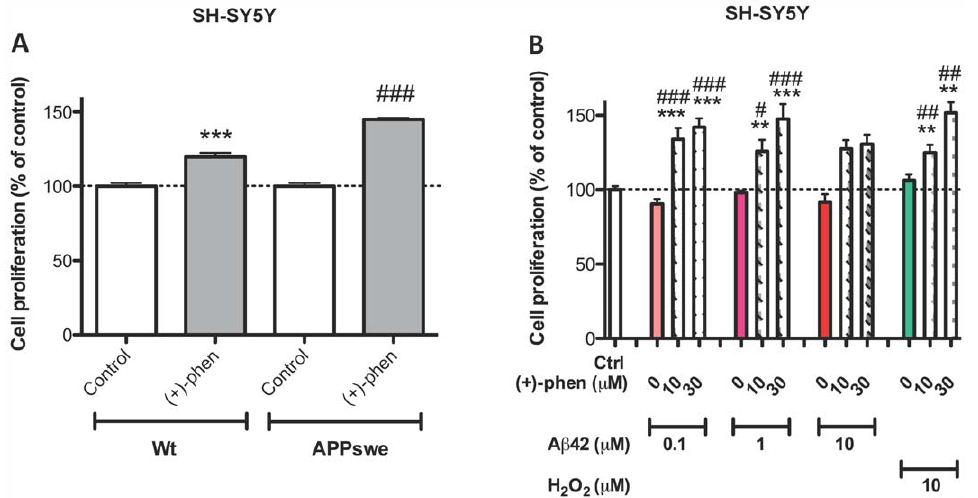
Figure 2. Neurotrophic actions retained in APPswe transfected and wt SH-SY5Y cells challenged with A b 42 and H 2 O 2 . Cells were exposed to ( + )-phenserine (30 m M) for 24 hr before measuring cell proliferation using MTS assay in (A). 10 or 30 m M ( + )-phenserine was added 24 hr before adding 0.1, 1 or 10 m M A b 42 or 10 m M H 2 O 2 before measuring cell proliferation in untransfected SH-SY5Y cells (B). **p , 0.01, and ***p , 0.001 compared to control samples without drug, ## p , 0.01 and ### p , 0.001 compared to samples with ( + )-phenserine only (one-way ANOVA followed by Bonferronis multiple comparison post hoc test). Results are expressed as mean 6 SEM.